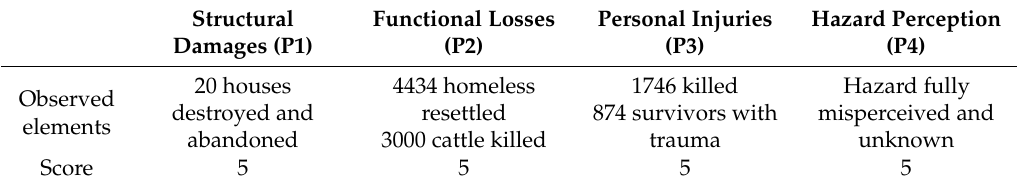
Table 4. Severity assessment of the lake Nyos volcanic